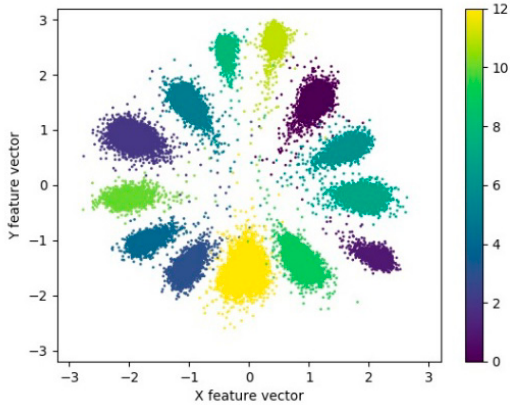
Figure 14. Visualization of the feature extracted by model A.